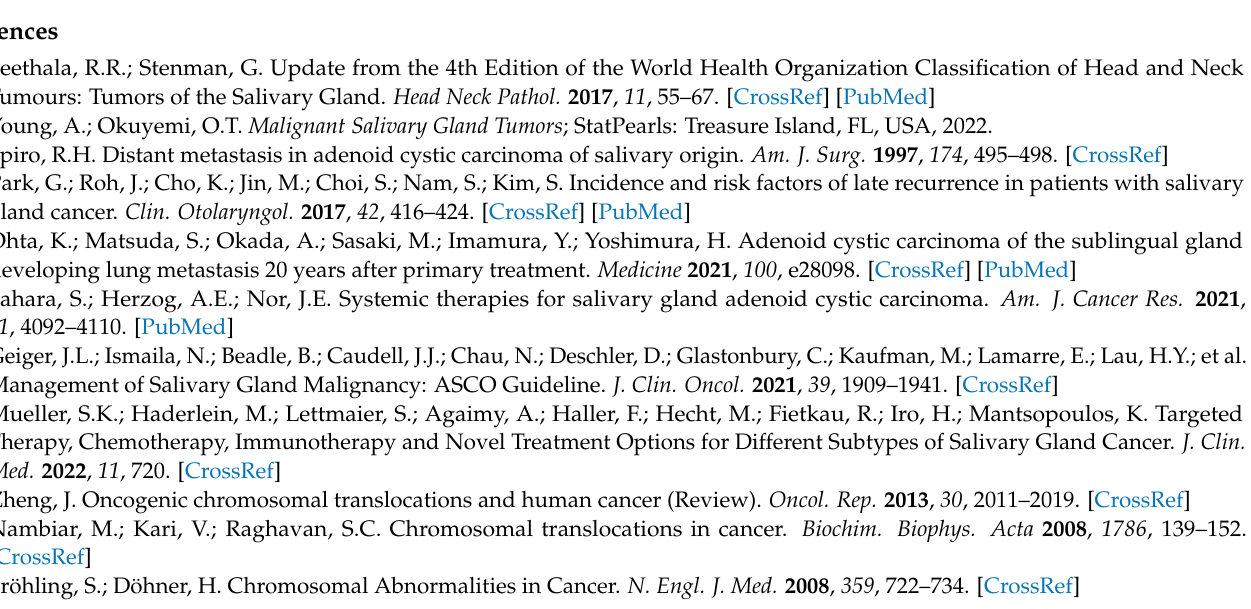
Figure S2: Original Western blots for data shown in Figure 3C,D. Figure S3: MYB-NFIB fusion expression in ACCX11 and ACCX20M1; Figure S4: In vitro growth activities of MYB-MNFIB fusion in ACC cells; Figure S5: Original Western blots for data shown in Figure 4A,C,E. Figure S6: Differential protein stability of MYB wt and MYB-NFIB fusion variants. Figure S7: Original Western blots for data shown in Figure